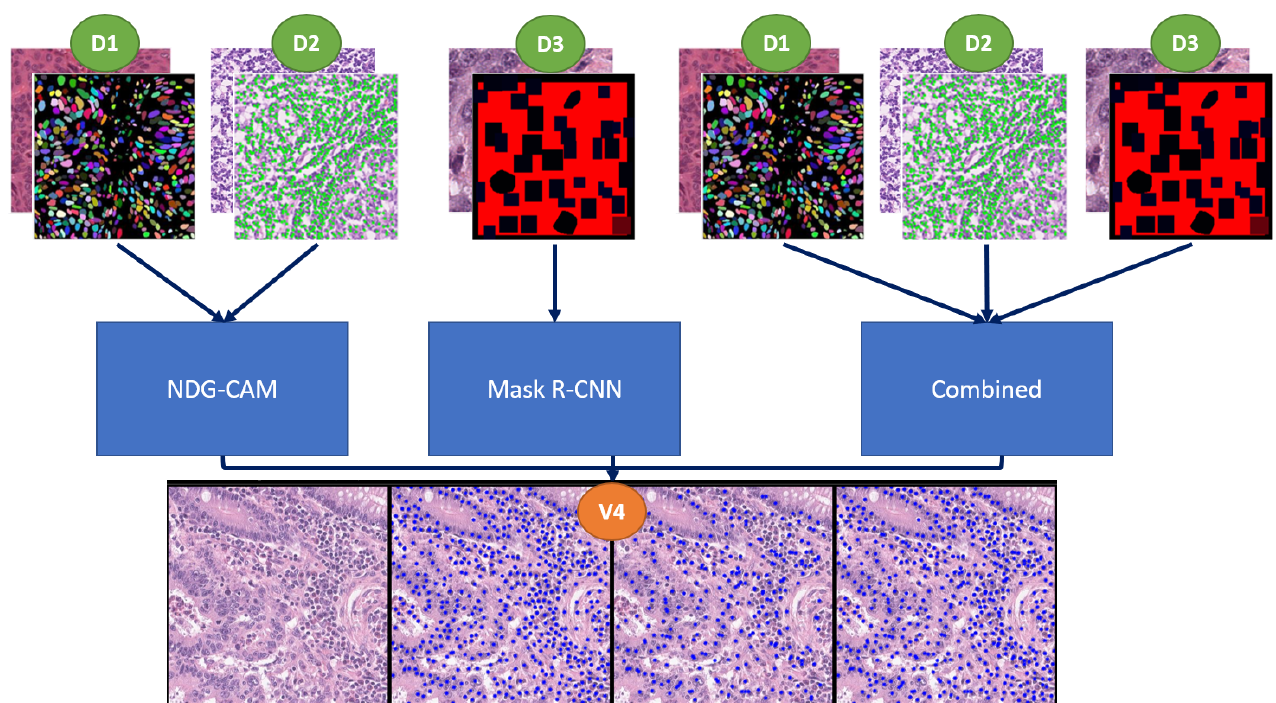
Figure 1. Pipeline adopted for training and validation. D1 and D2 datasets have been used to train and select the best semantic segmentation network. D3 dataset has been exploited to train the Mask R-CNN instance segmentation architecture. Finally, external validation has been conducted on the local validation dataset V4.